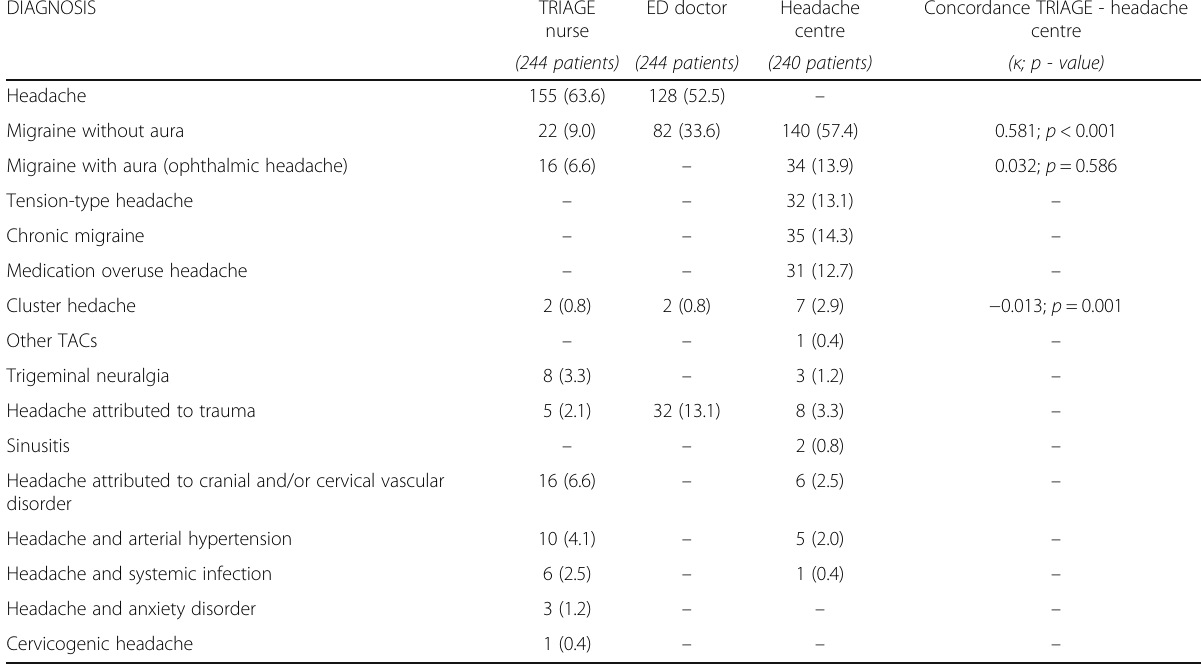
Table 2 Changes in diagnoses in relation to the clinical evaluation setting